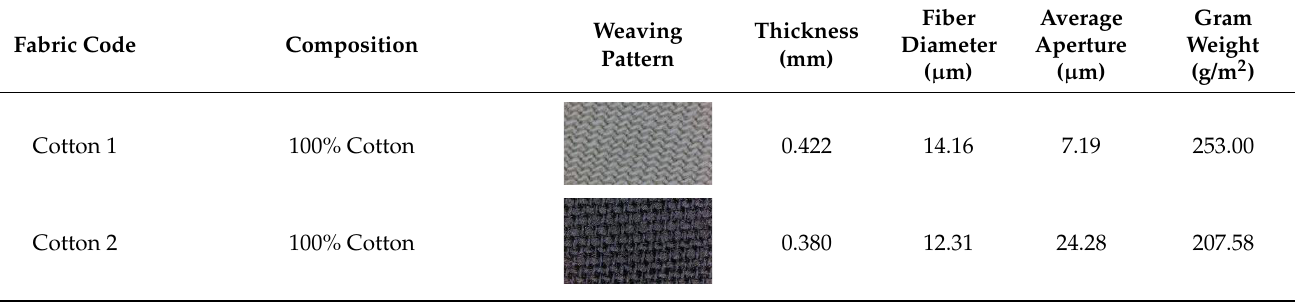
Table 1. The basic structure parameters of these fabrics.